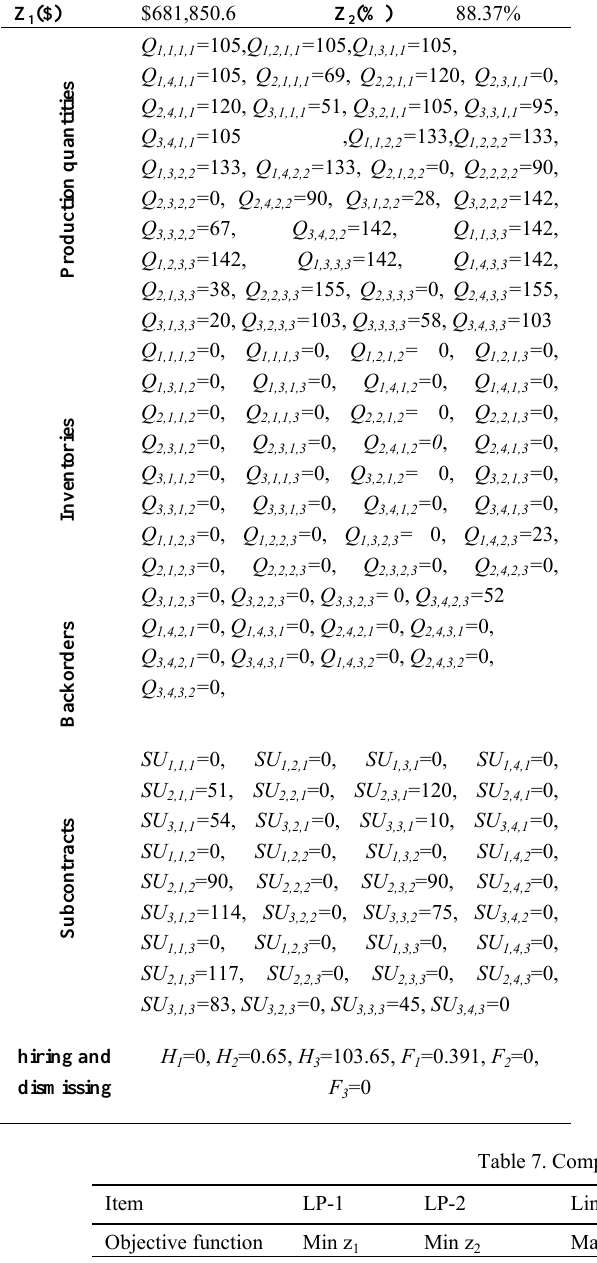
Table 6. Optimal solution obtained by solving the proposed FMOLP model